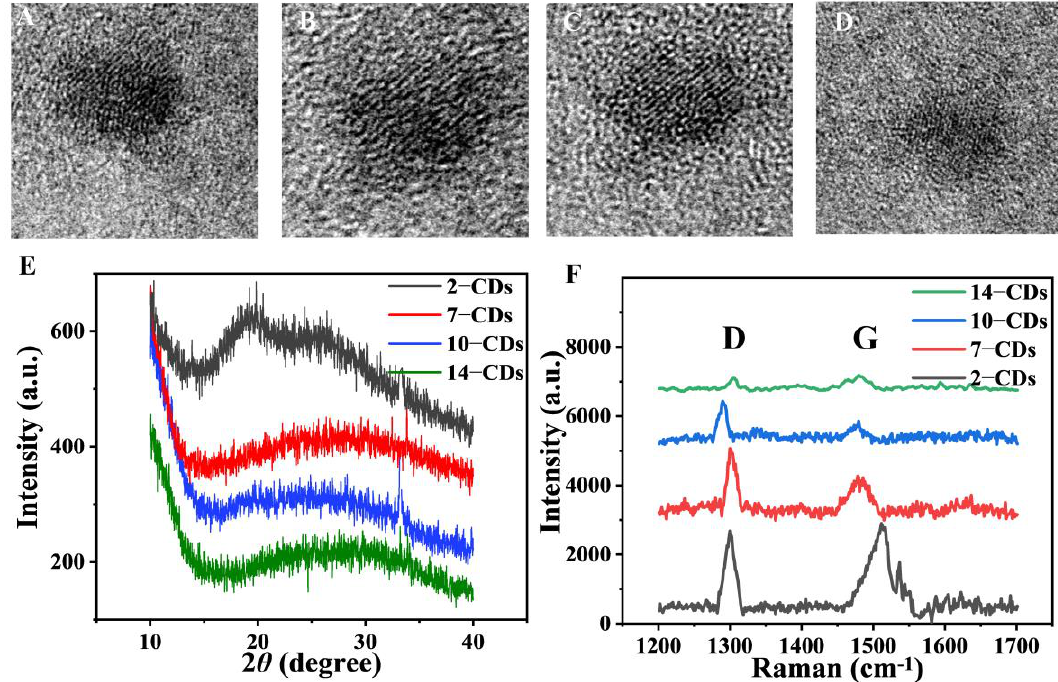
Figure 1. HRTEM images of the ( A ) 2 − CDs, ( B ) 7− CDs, ( C ) 10− CDs and ( D ) 14− CDs. ( E ) XRD and ( F ) Raman spectra of the 2−CDs, 7−CDs, 10−CDs and 14− CDs (D peak representing C atom defect and G peak representing C atom stretching